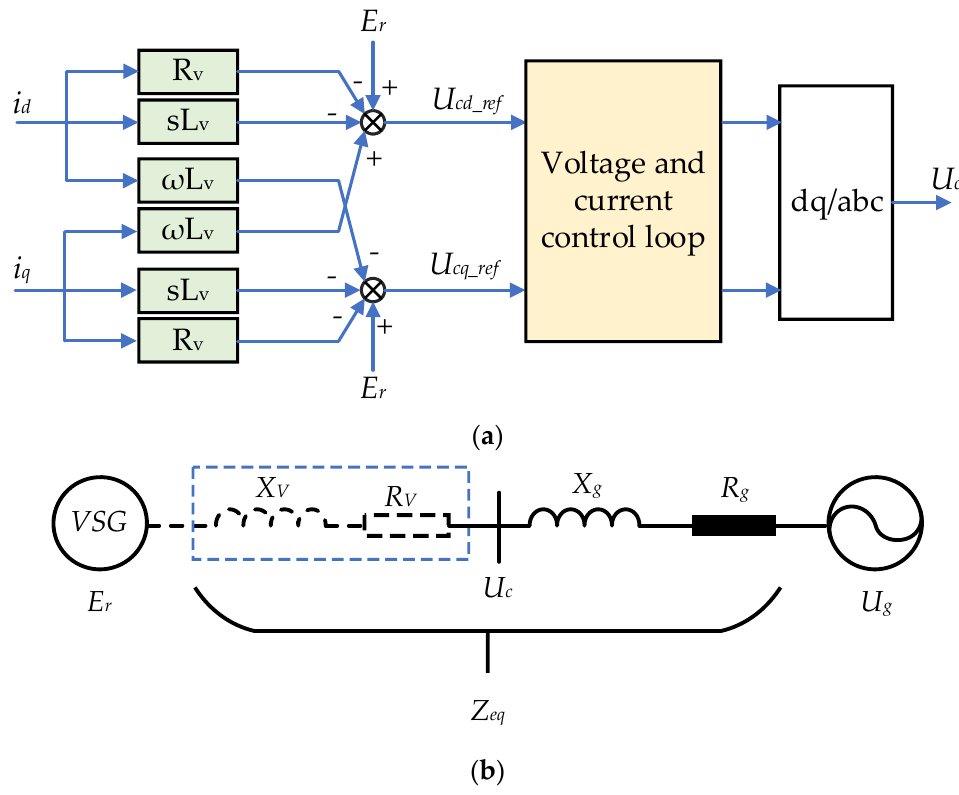
Figure 16. ( a ) Virtual impedance control; ( b ) Fundamental equivalent circuit.